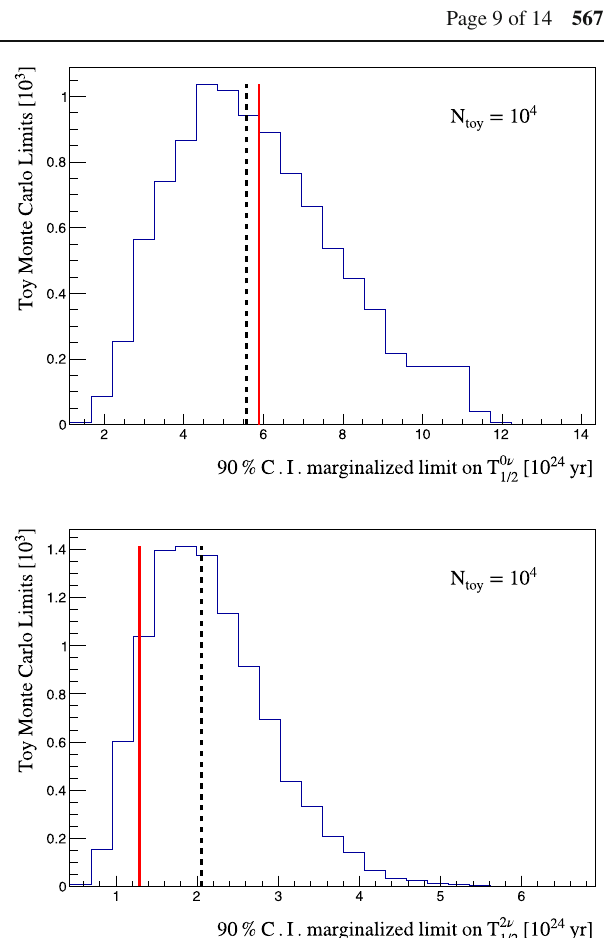
Fig. 2 Distribution of 90% C.I. marginalized upper limits on T 1 / 2 = log2 /(cid:12) for 0 νββ decay (top) and 2 νββ decay (bottom) obtained from Toy MC simulations. We obtain a median sensitivity of S 0 ν = 5 . 6 × 10 24 yr (black dashed line), compared to the 10 24 yr and S 2 ν 1 / 2 90% C.I. limit from this analysis (red solid line)